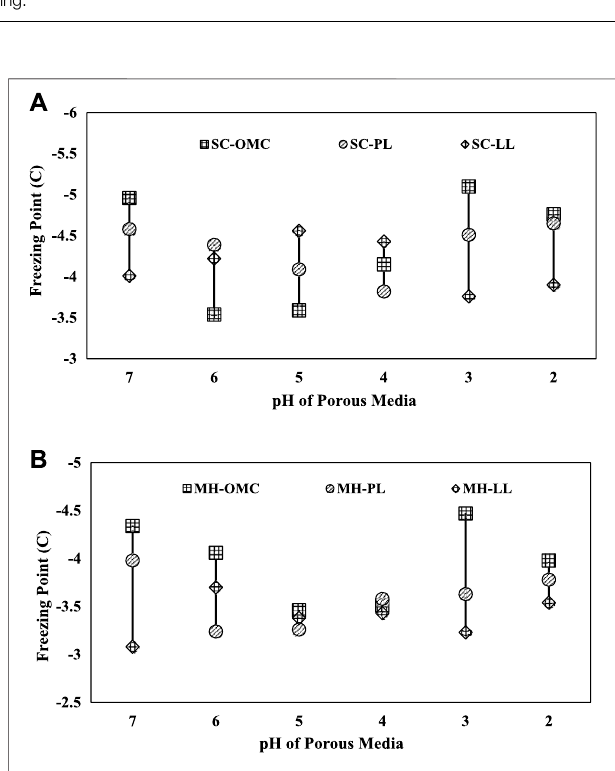
FIGURE 2 | Freezing point phase changes for SC and MH soil with the rate of cooling.